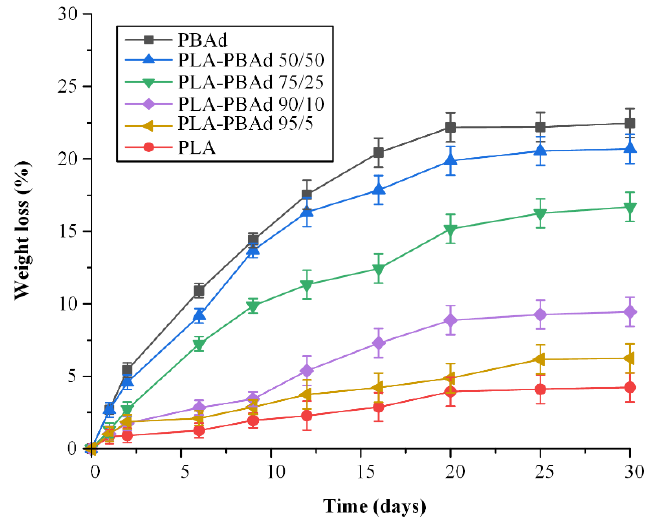
Figure 3. The enzymatic hydrolysis profile measured as % weight loss vs. time plots for the neat PBAd, the neat PLA and the various PLA/PBAd block copolymers.